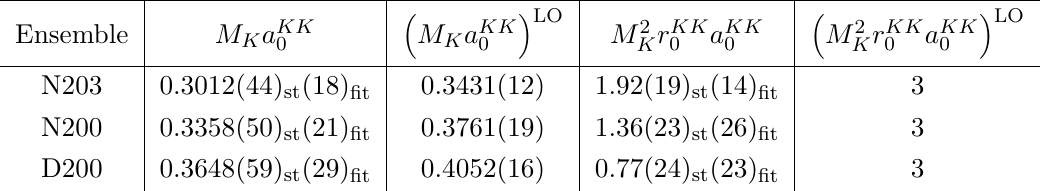
Table 17. Two-kaon threshold parameters from fit 4 in tables 9 to 11, with systematic errors due to choice of fit obtained as discussed in the text.